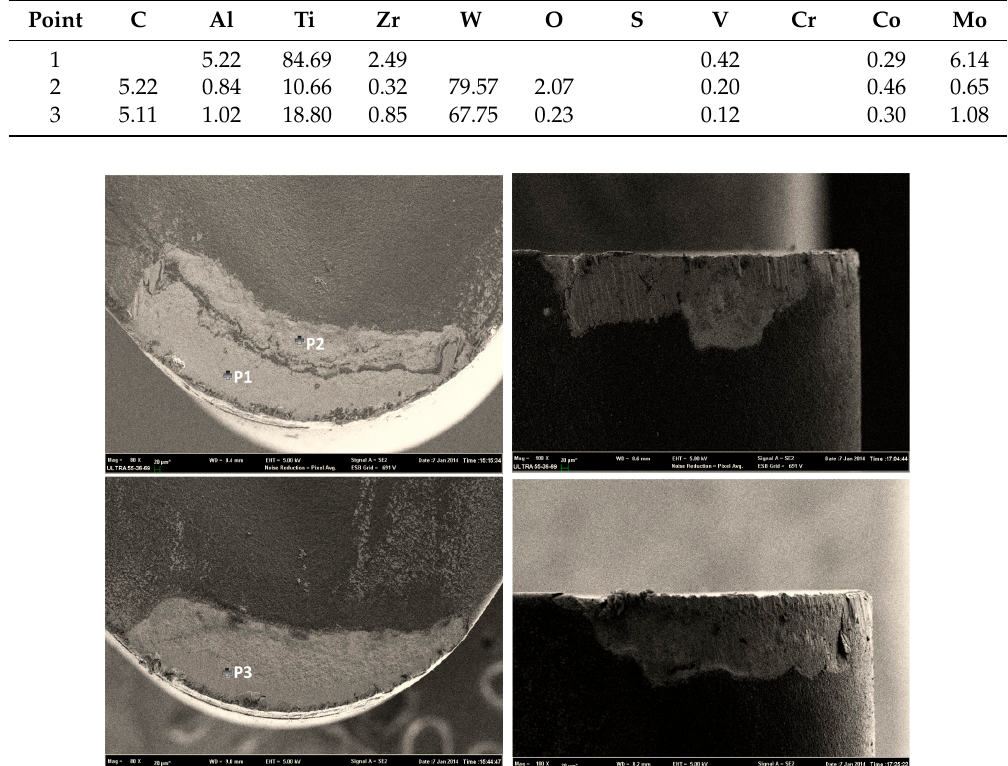
Figure 8. SEM and EDS results of diamond-coated insert under dry and MQL conditions.